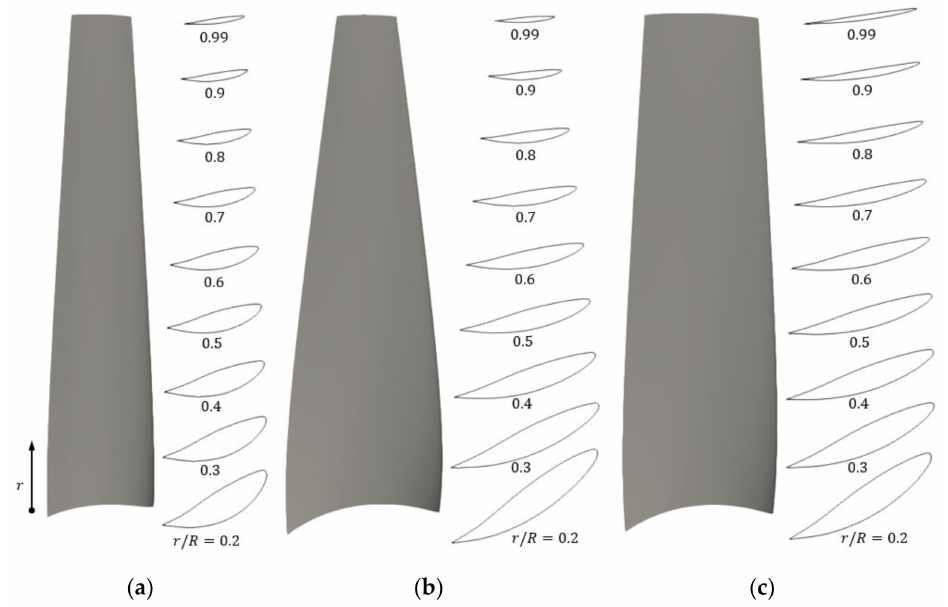
Figure 3. Cross sections and 3D blade geometry: ( a ) Initial geometry; ( b ) optimized geometry A.1; ( c ) optimized geometry